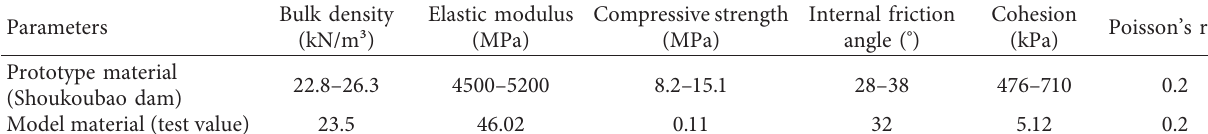
Table 3: Physicomechanical test parameters of the material.